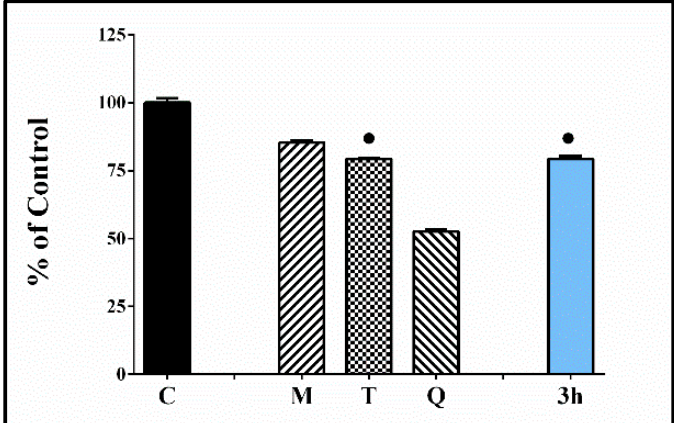
Figure 8. Effect of the tested hydrazone derivative 3h [80 μ mol/L] on the in vitro Fe(II) induced degradation of 2-deoxyribose [0.5 mmol/L]. Melatonin, Trolox, and Quercetin at the same concentrations have been used as reference compounds. All data are expressed as Mean ± SEM. The effect of the compound labeled with ● is considered statistically identical ( p < 0.05) compared with the effect of Trolox.